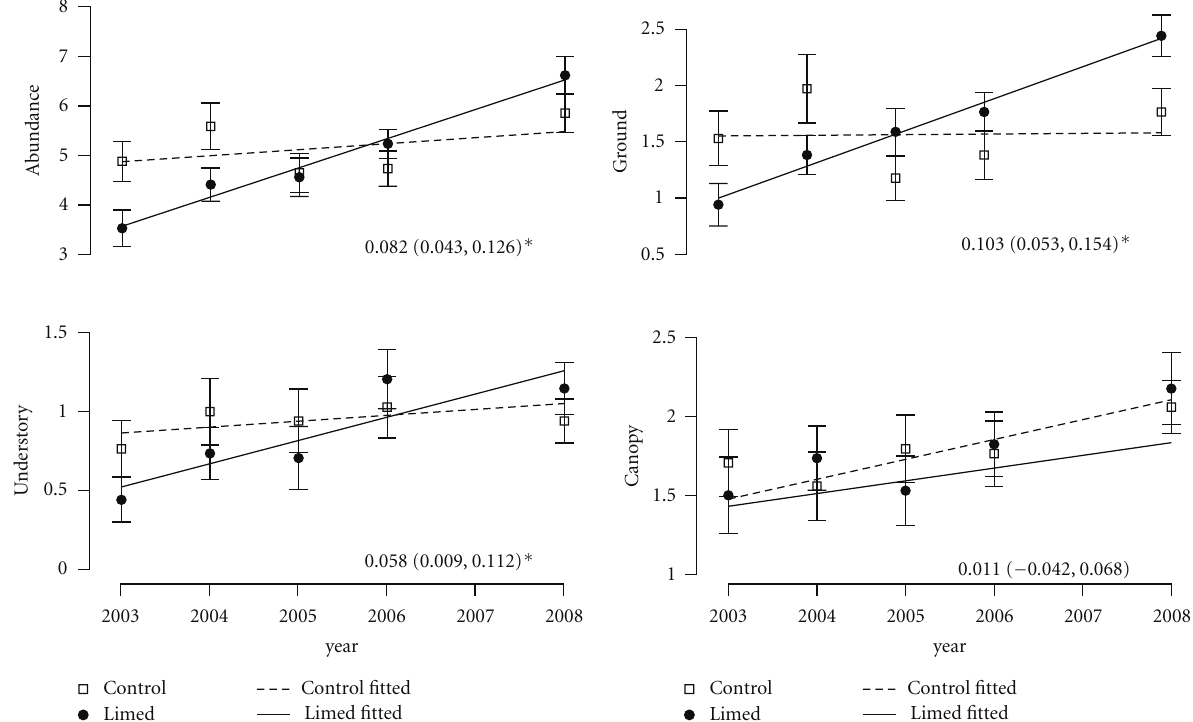
Figure 4: Mean number of all birds (abundance) and of ground-, understory-, and canopy-foraging birds (birds per point) with SE bars and model lines on lime-treated and control sites. Lime treatment was applied between 2003 and 2004 in central Pennsylvania. ∗ Confidence intervals of the time-by-treatment interaction excluded zero, indicating a significant e ff ect of liming on that variable.